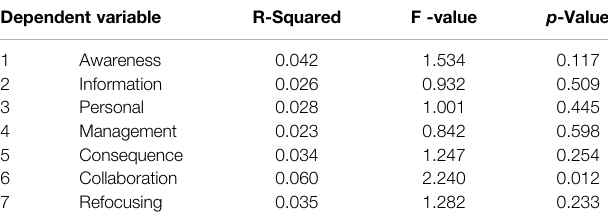
TABLE 6 | Coef fi cients table for the CBAM stages.